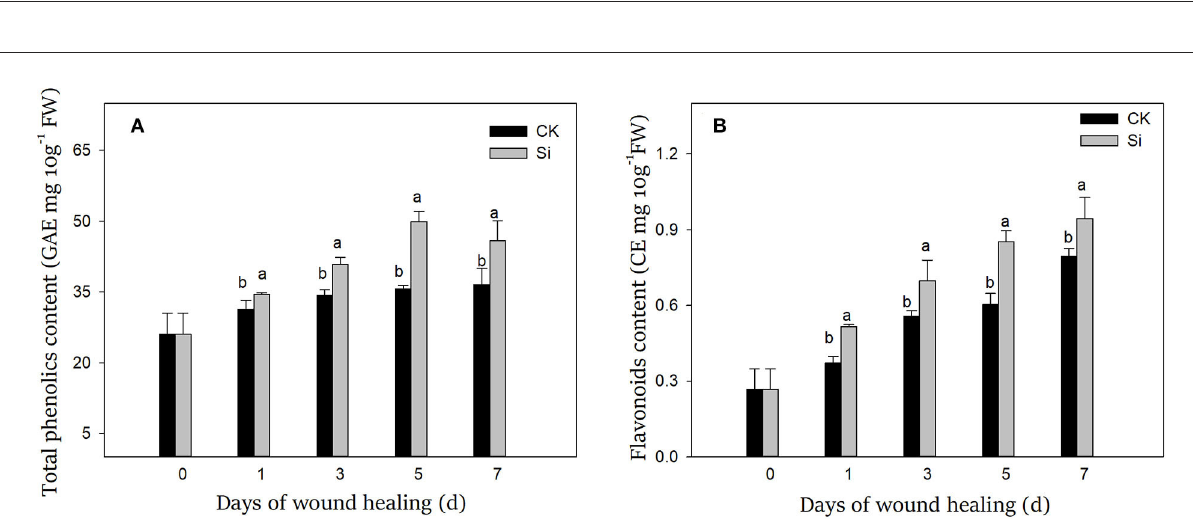
FIGURE6 Effect of sodium silicate treatment on the contents of total phenolics (A) and flavonoids (B) . Vertical bars indicate the standard error of three replicate assays. Columns with different letters at each time point are significantly different (LSD, P <